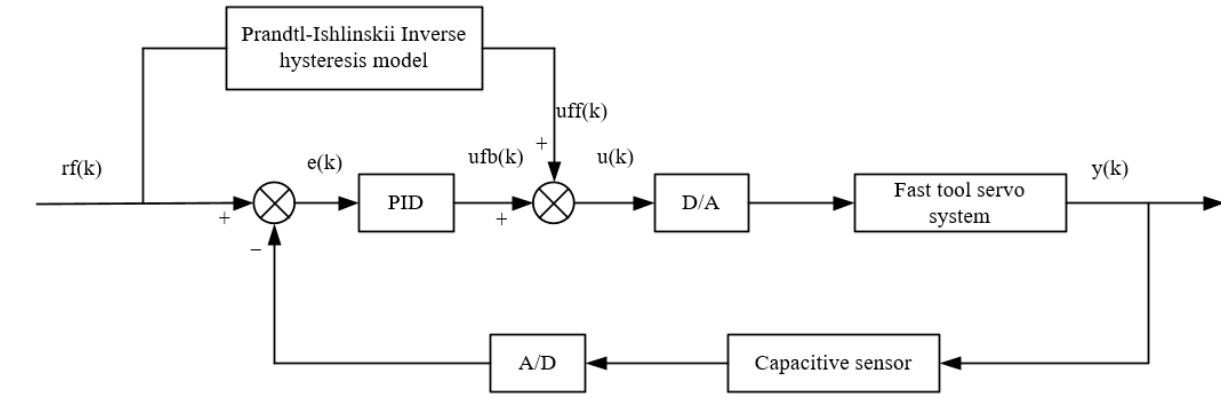
Figure 8. PID control based on the modified Prandtl–Ishlinskii inverse hysteresis model.